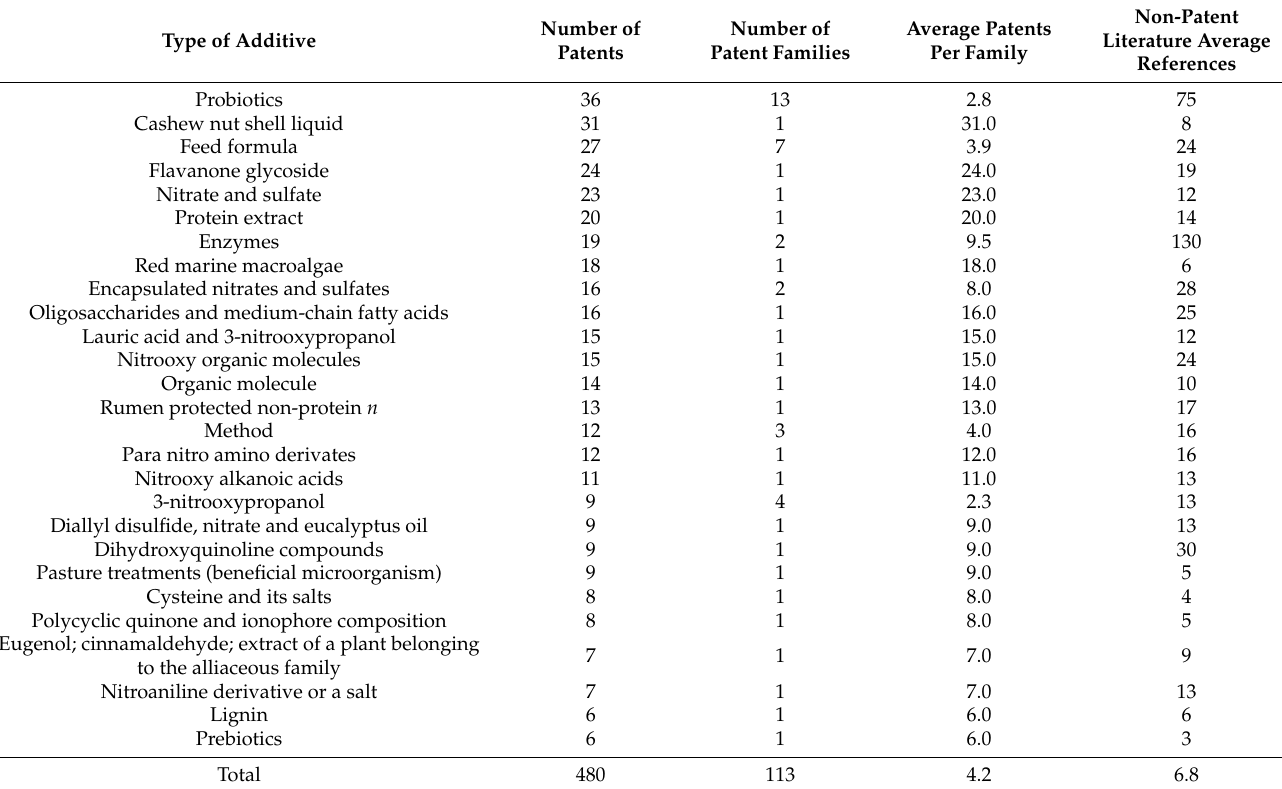
Table 2. Main types of additives and relative patent production (>5